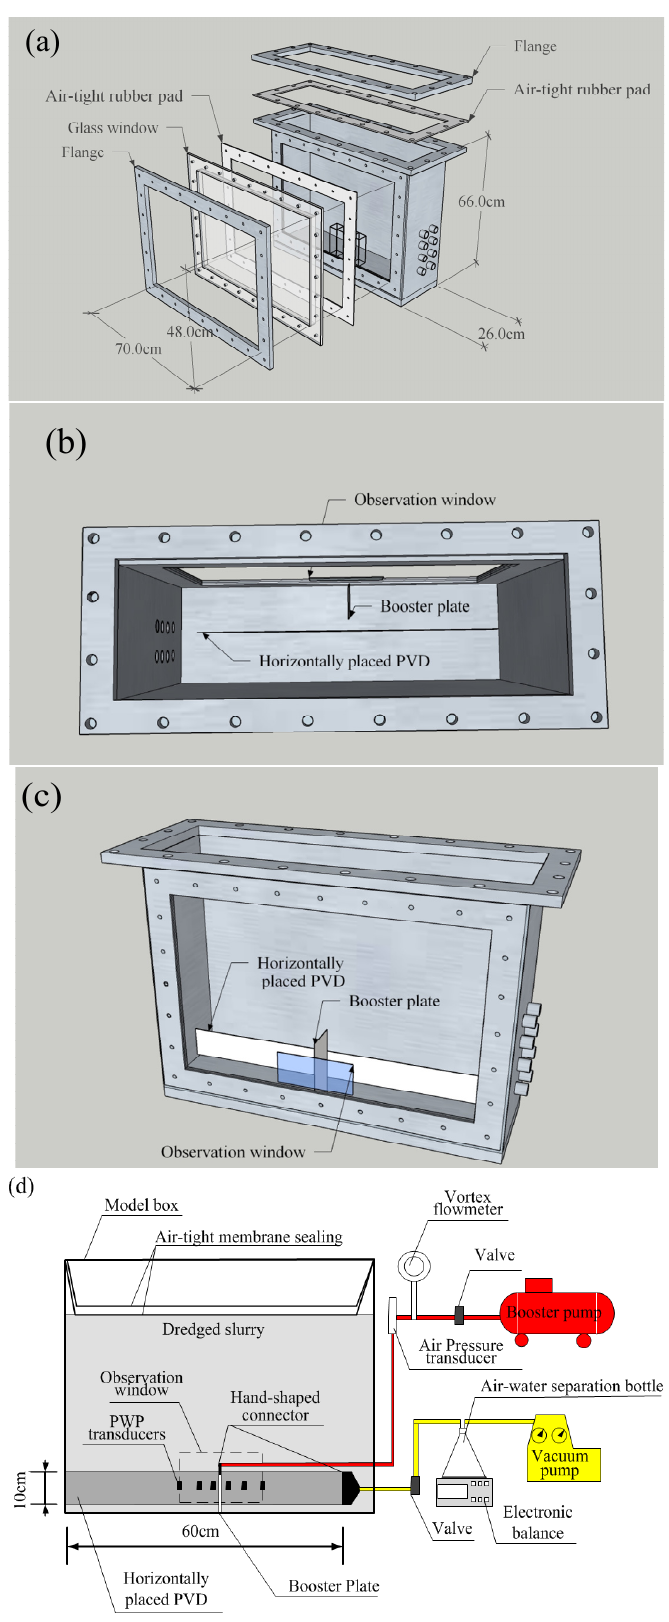
Figure 3. Schematic view of the components of the model box: ( a ) right-side view; ( b ) top view of the relative positions of the PVD and booster plate; ( c ) front view of the relative positions of the PVD and booster plate; ( d ) schematic view of the arrangements of the components for the model